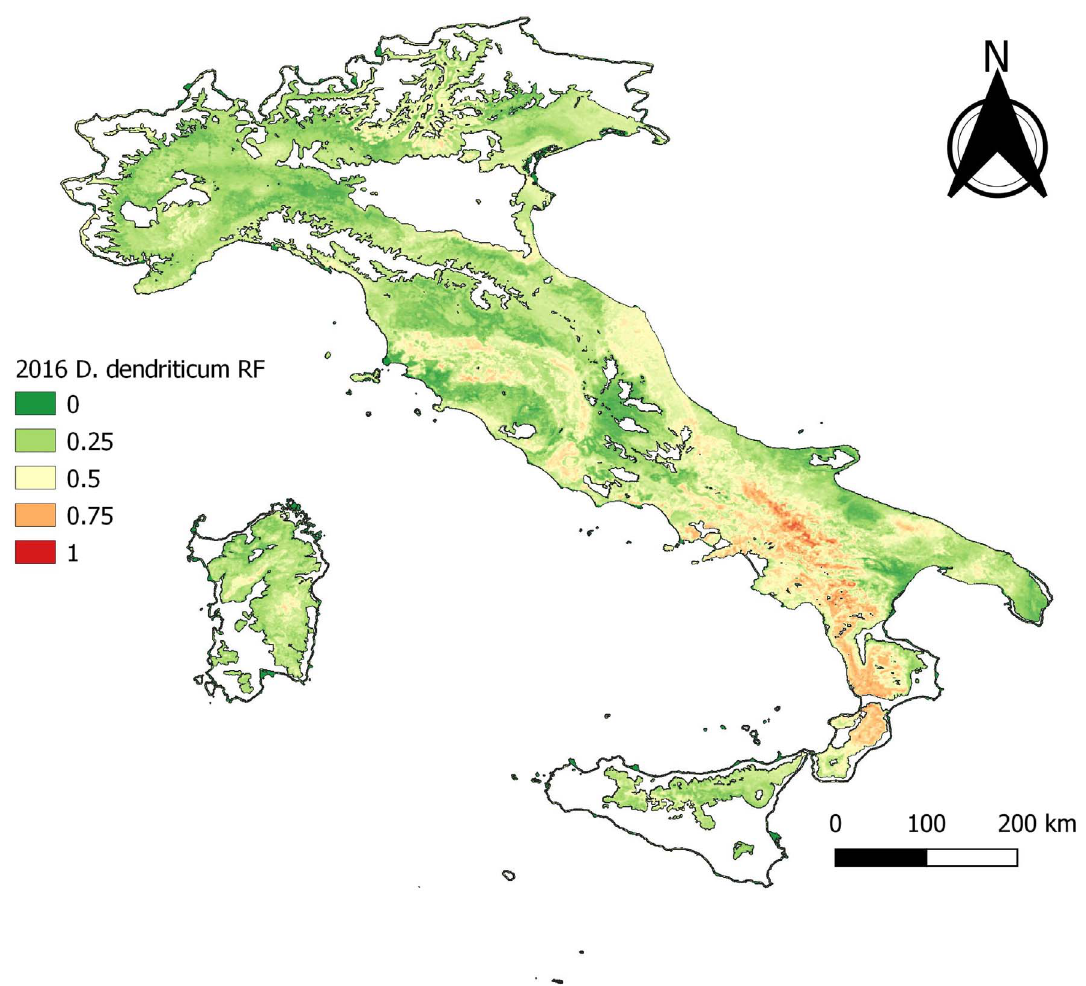
Figure 9. Annual distribution model